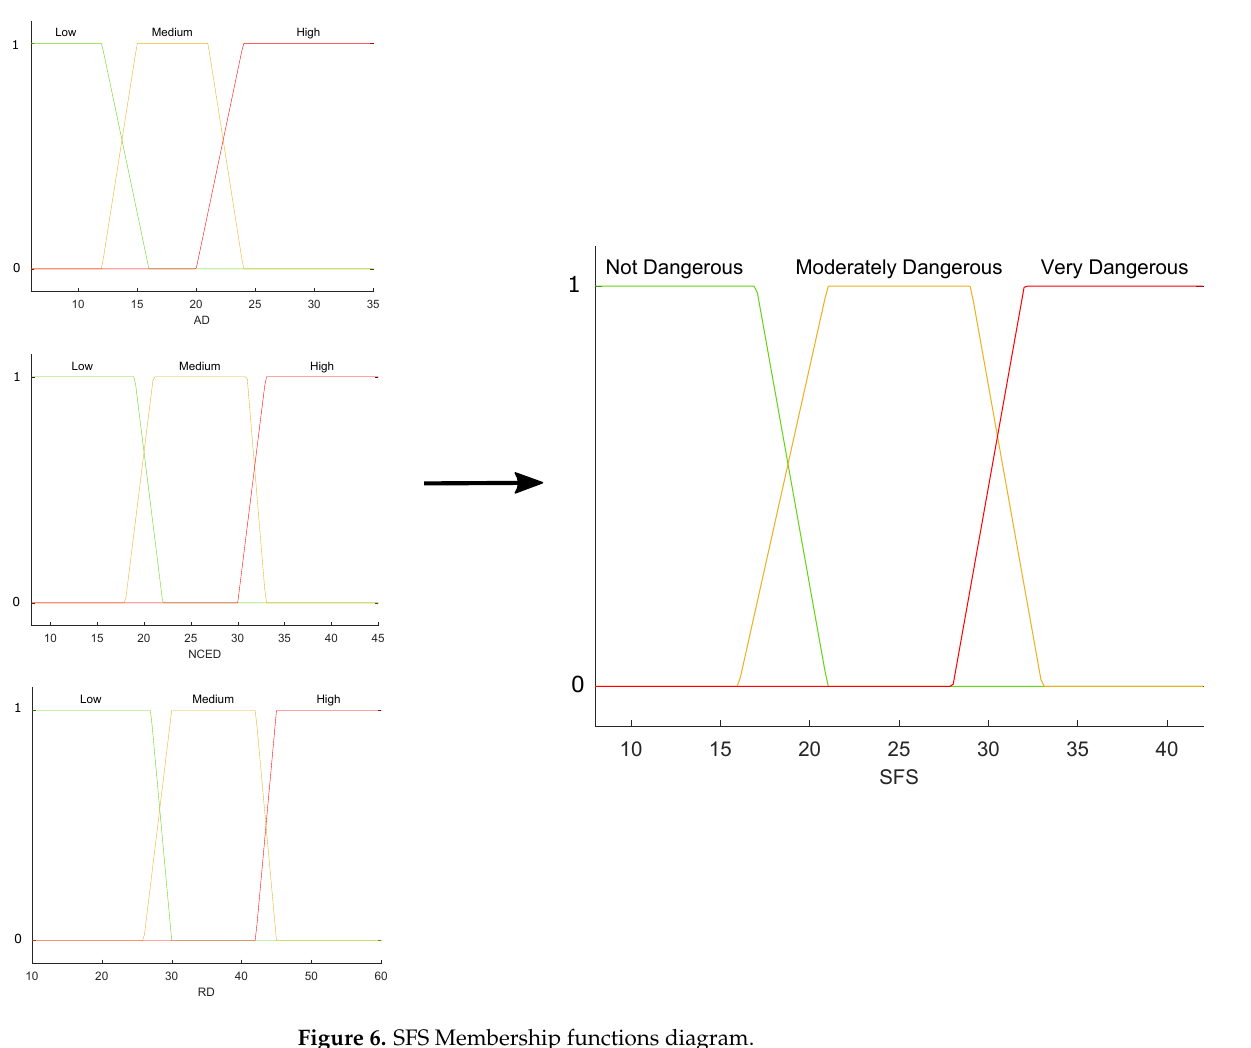
Figure 6. SFS Membership functions diagram.